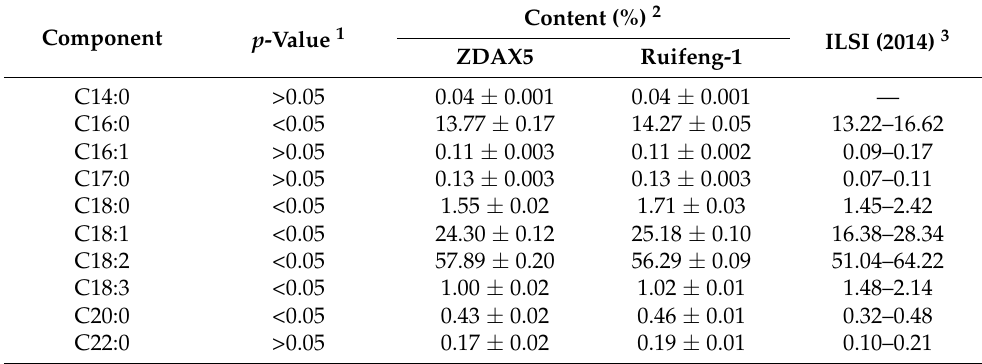
Table 3. Fatty acid levels in ZDAX5 maize grain and Ruifeng-1 maize